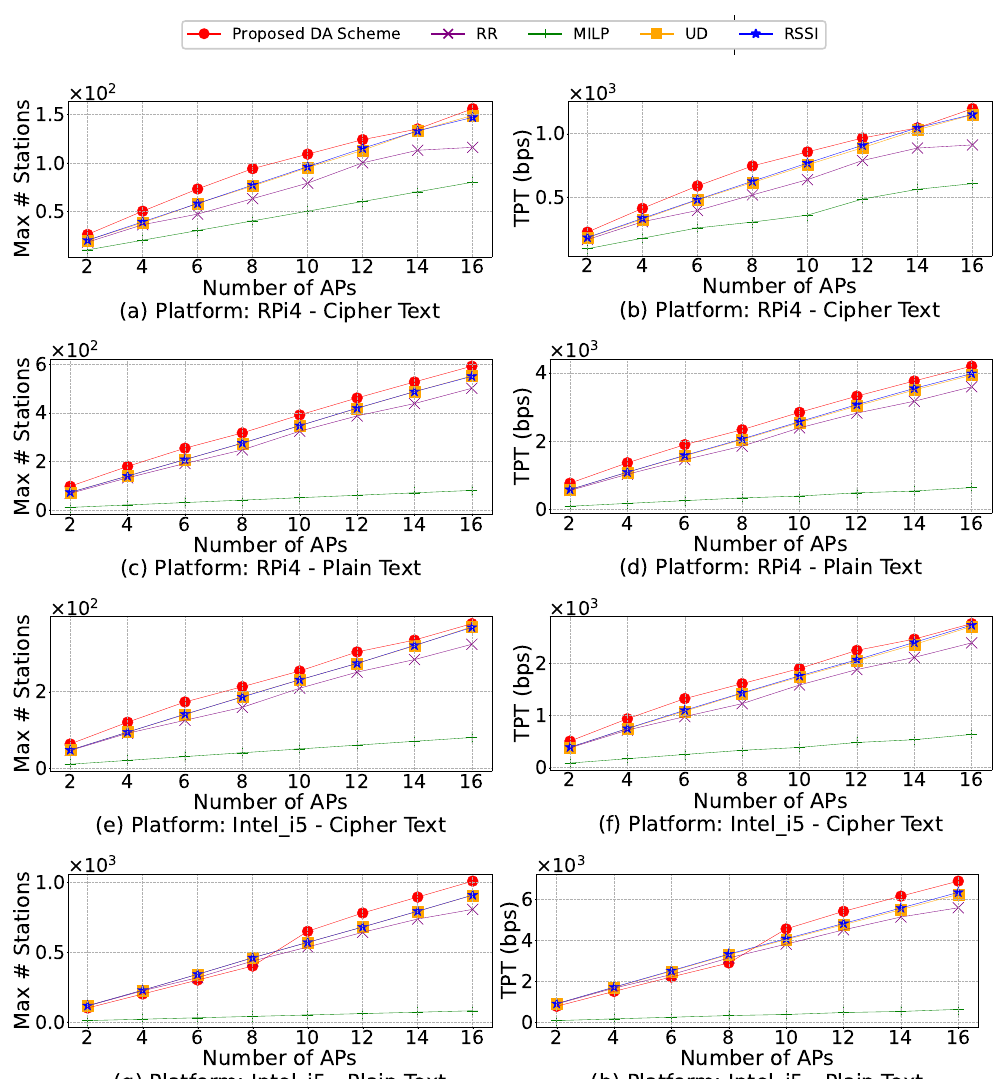
Figure 10. Simulation results for all five algorithms on RPi4 and Intel_i5 platforms for cipher text and plain text. These plots show how each algorithm performs in terms of the network throughput (TPT), which is measured in bits per second (bps) and the maximum number of devices